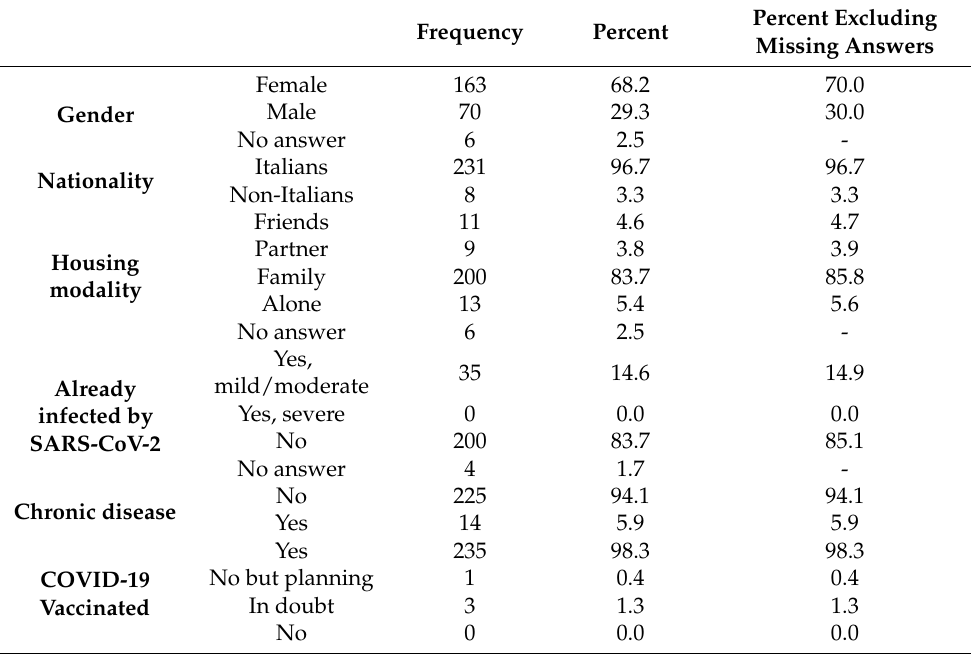
Table 1. Socio-demographic features and health